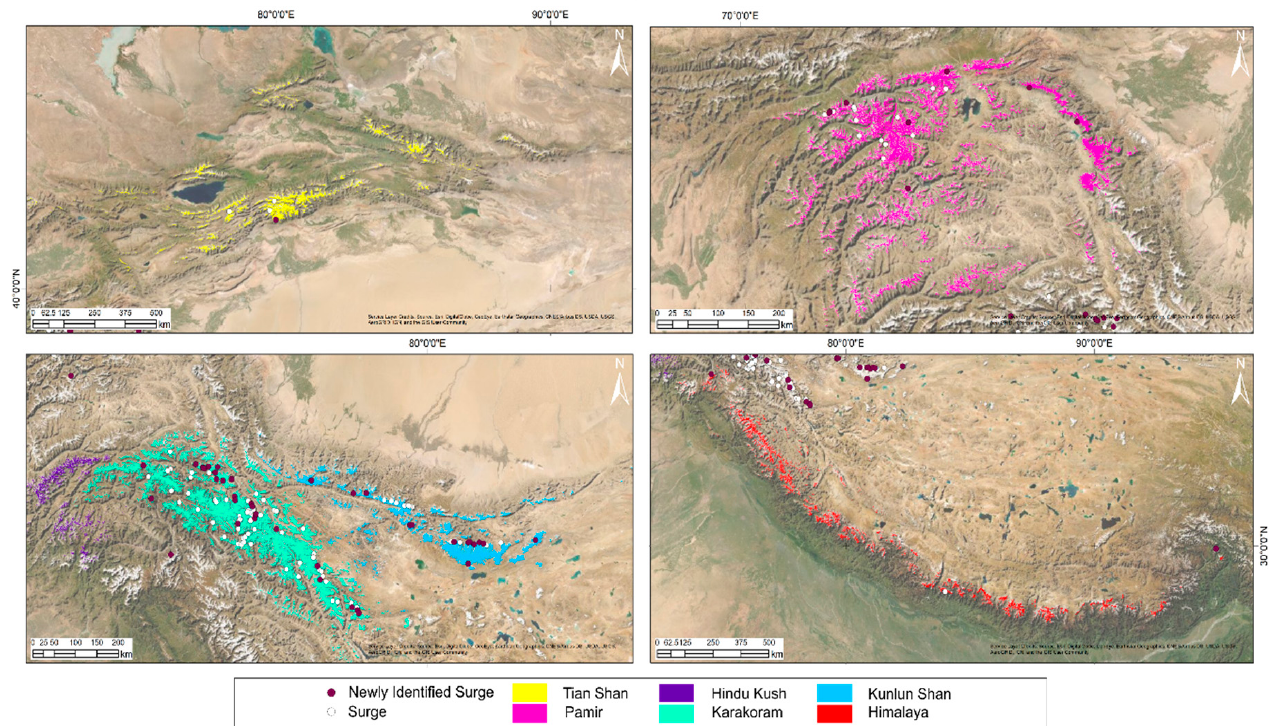
Figure 4. Glacier surges identified and digitised using GEEDiT. Tian Shan ( top left ), Pamir ( top right ), Karakoram and West Kunlun Shan ( bottom left ), and Himalaya ( bottom right ). Glacier outlines taken from RGI, v6.0 (RGI Consortium, 2017).